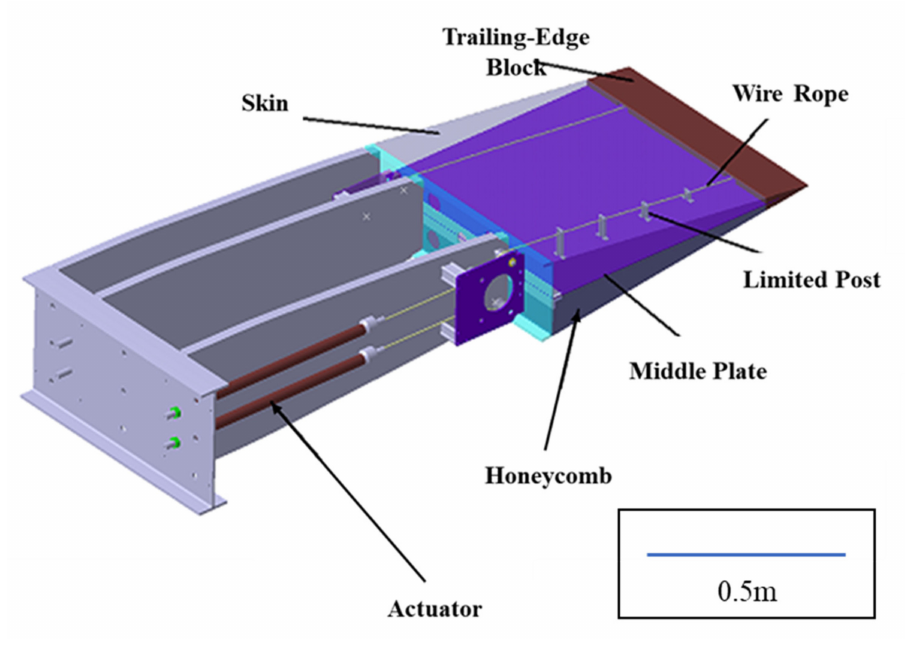
Figure 1. Flexible trailing edge structure.